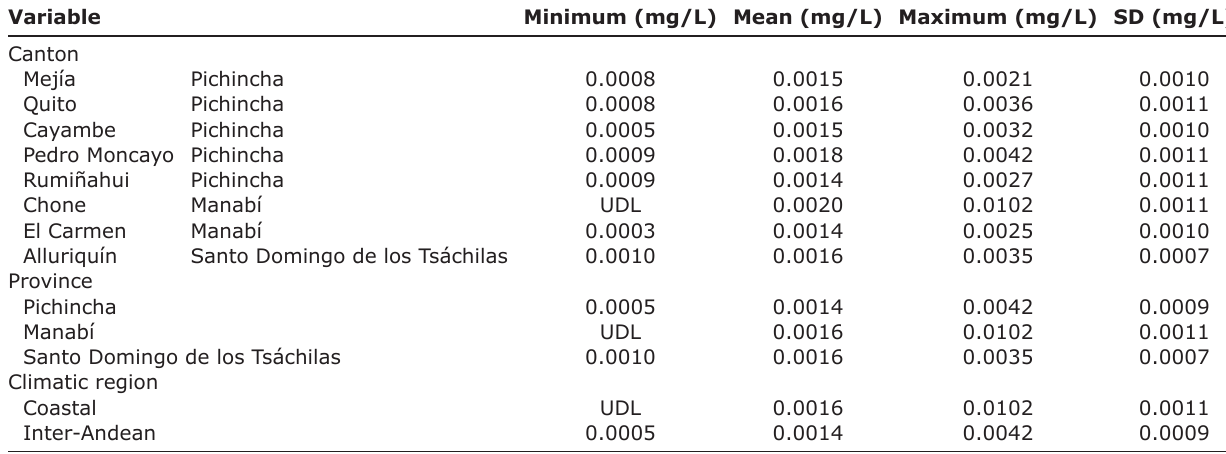
Table-1: Minimum, mean, and maximum values of ZEA obtained by cantons, provinces, and climatic regions (n=209).